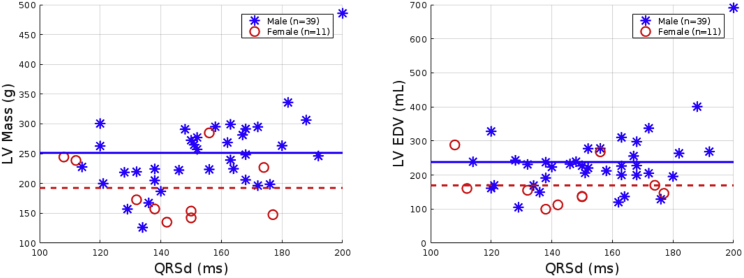
LV size measures in relation to the QRSd for the 50 patient cases. The mean LV size measures for the male (blue stars) and female (red circles) cohorts are shown as solid and dashed lines, respectively. To see this figure in color, go online.